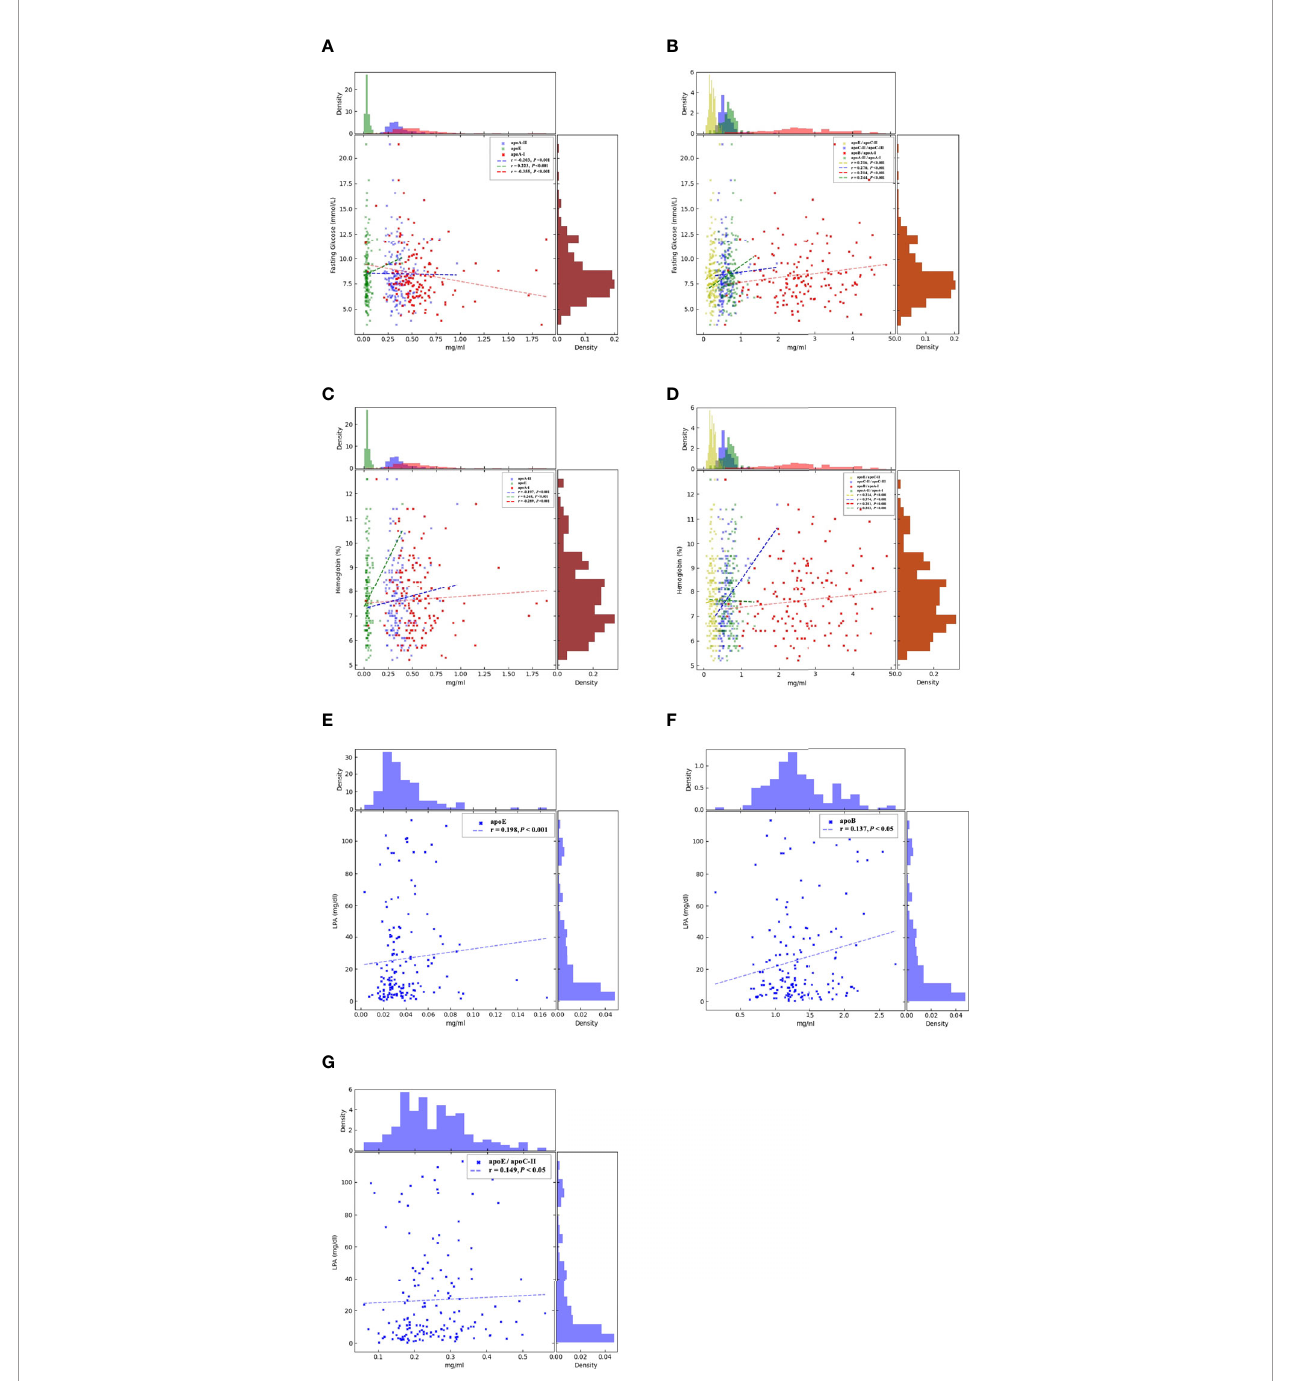
FIGURE 2 | Correlations between the circulating levels offasting glucose, hemoglobin, LPA, and the apolipoproteins by Spearman ’ s rank correlation coef fi cient analysis. (A) : apoA-I ( p < 0.001) and apoA-II ( p < 0.001) were signi fi cantly negatively correlated with fasting glucose, but apoE ( p < 0.001) was positively correlated. (B) . apoB/ apoA-I ( p < 0.001), apoC-II/apoC-III ( p < 0.001), apoA-II/apoA-I ( p < 0.001), and apoE/apoC-II ( p < 0.001) were signi fi cantly positively correlated with fasting glucose. (C) . apoA-I ( p < 0.001) and apoA-II ( p < 0.001) were signi fi cantly negatively correlated with hemoglobin, but apoE ( p < 0.001) was positively correlated. (D) . apoB/apoA-I ( p < 0.001), apoC-II/apoC-III ( p < 0.001), apoA-II/apoA-I ( p < 0.001), and apoE/apoC-II ( p < 0.001) were signi fi cantly positively correlated with hemoglobin. The brown histograms on the right side represent the data distribution offasting blood glucose (mmol/L) and hemoglobin (%). AI, atherogenic index was calculated as